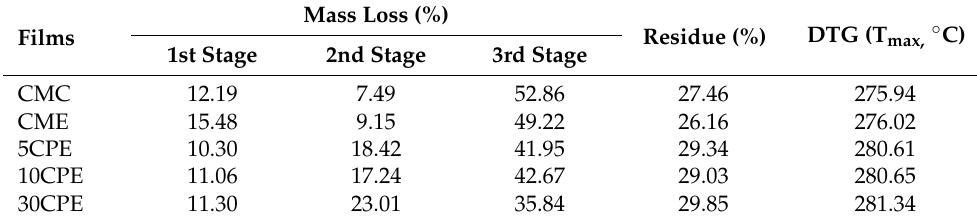
Figure 8. FRAP and ABTS antioxidant activities of films. Values represent mean ± SD ( n = 3), and different superscripts denote significant differences (DMRT, p < 0.05).